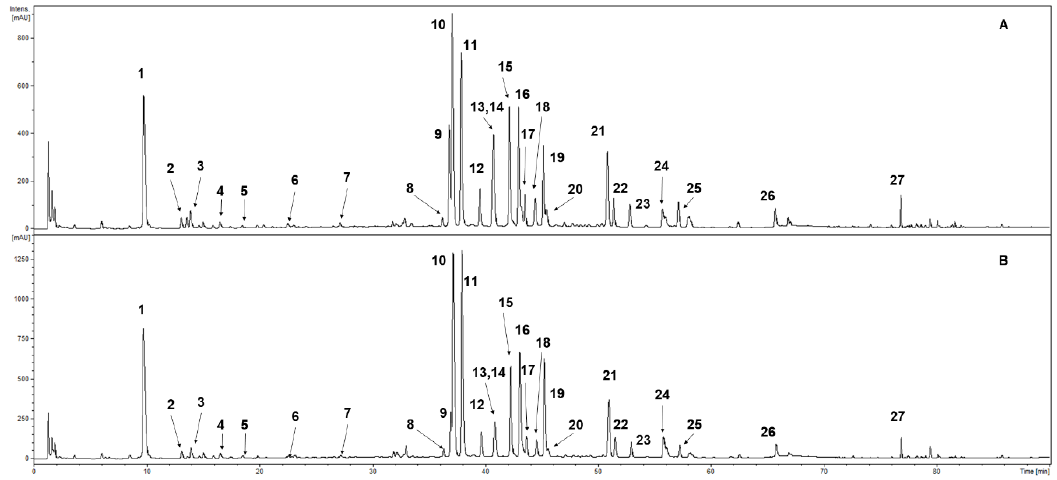
Figure 2. UHPLC-DAD-ESI-MS 3 chromatogram of S. rubriflora leaf extract separation of the phenolic compounds (at 254 nm): ( A ) female (F) specimen; ( B ) male (M) specimen. For compound numbers,